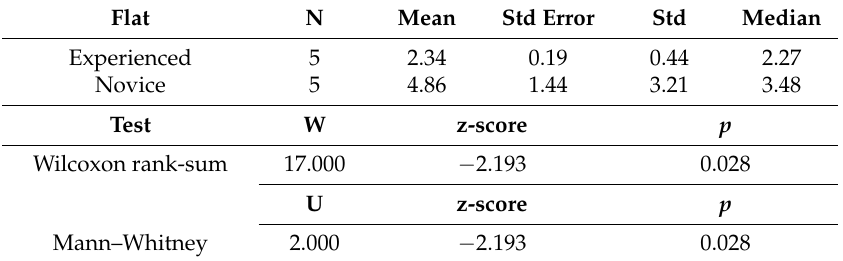
Table 17. Test for correlation between user skills level and task duration in skeuomorphic design. Flat